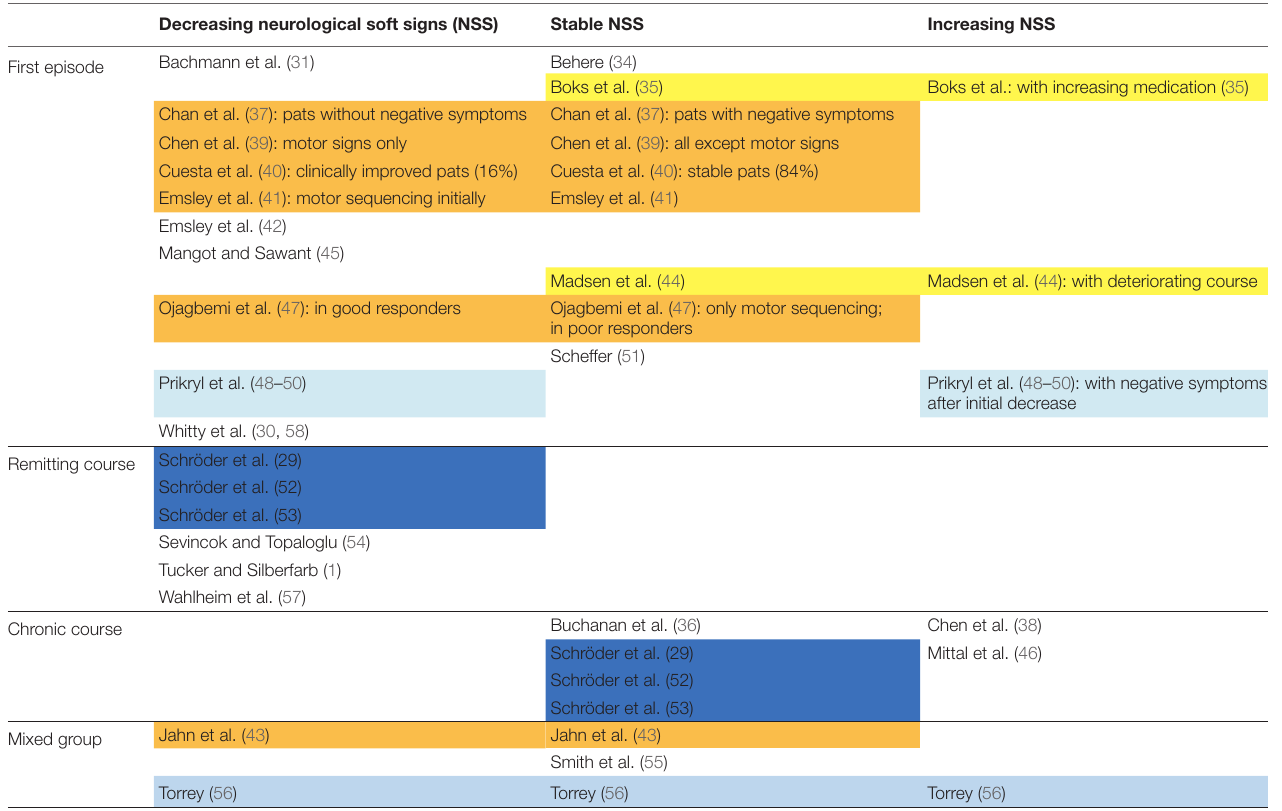
TABle 2 | Follow-up studies in schizophrenia and NSS course (decreasing – stable – increasing). Decreasing neurological soft signs